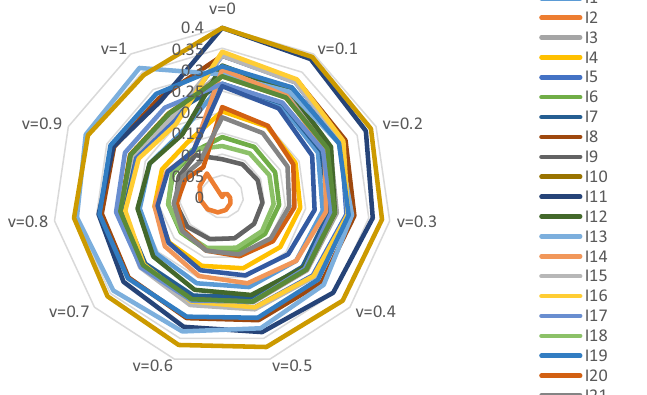
Figure 2. Sensitivity analysis of “ Q ” values